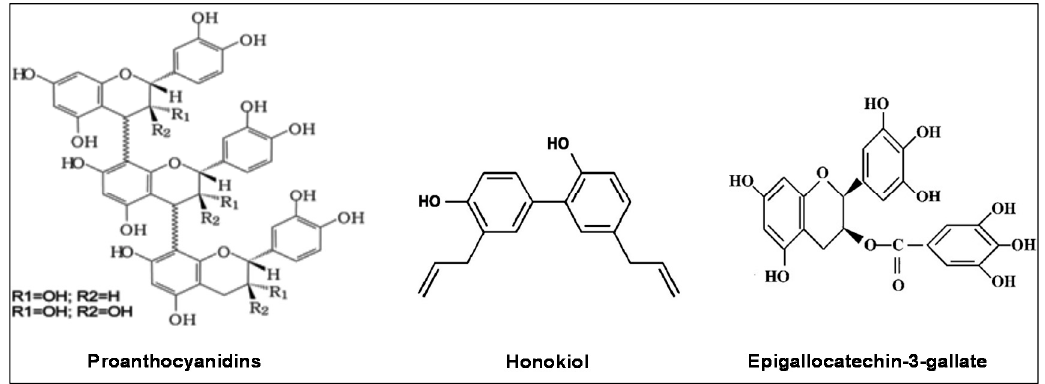
Figure 1. Molecular structures of phytochemicals that have shown promise for therapeutic use in the management of head and neck cancer. Proanthocyanidins are shown as polymers of catechin monomers.